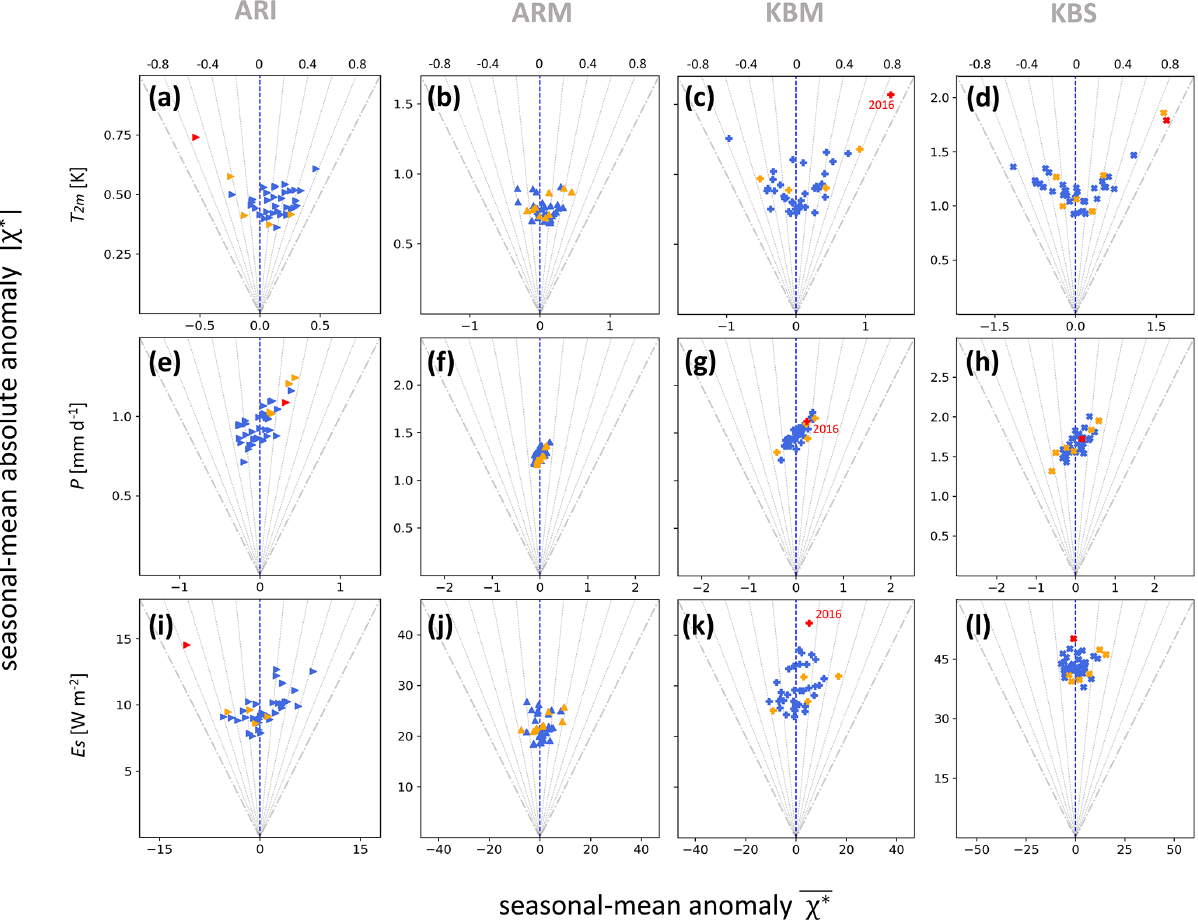
Figure 6. Same as Fig. 5 but for JJA in sub-regions ARI, ARM, KBM and KBS. The extreme summer 2016 is labeled in panels (c) , (g) and (k) due to its role in the preconditioning of the extreme winter 2016/17 (see Sect. 5.2). Remaining sub-regions are shown in Fig.